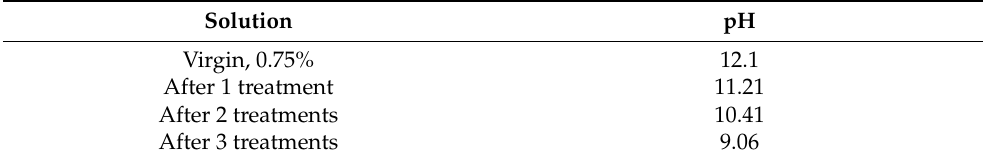
Table 2. Values of the pH for different solutions.